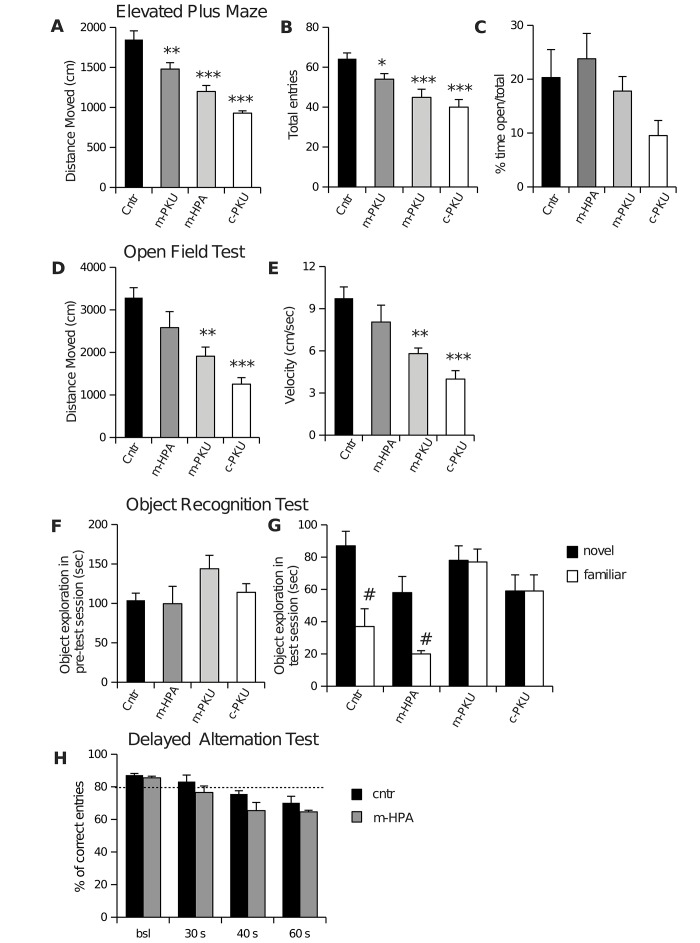
Behaviors of HPA mice.Elevated Plus Maze (A, B, C). Compared to Cntr mice, all other groups showed decrease in distance moved (B) and total entries (A), but no significant differences in the percent of time and entries in open arms (B). Open Field Test (D, E). Compared to Cntr mice, m-PKU and c-PKU showed significant decrease in distance moved (D) and velocity (E). Object Recognition Test (F, G). Results are expressed as mean time spent exploring the two identical objects during pre-test session (F) and as time spent exploring either the novel or the familiar object during test session (G). Only Cntr and m-HPA mice showed object recognition ability, spending more time exploring novel object that the familiar one. Delayed Alternation Task (H). The performance below the criterion level (dotted line) was evident in the m-HPA mice after the shortest delay (30 sec).All data are are expressed as means + S.E.M.*,*** p<0.05, 0.001 vs. all other groups; # p<0.05 vs. familiar object.